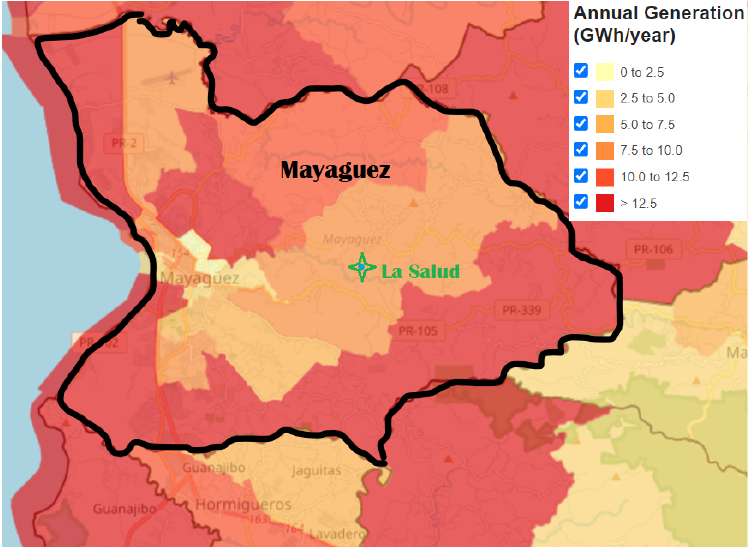
Figure 4. NREL’s tools—Solar for